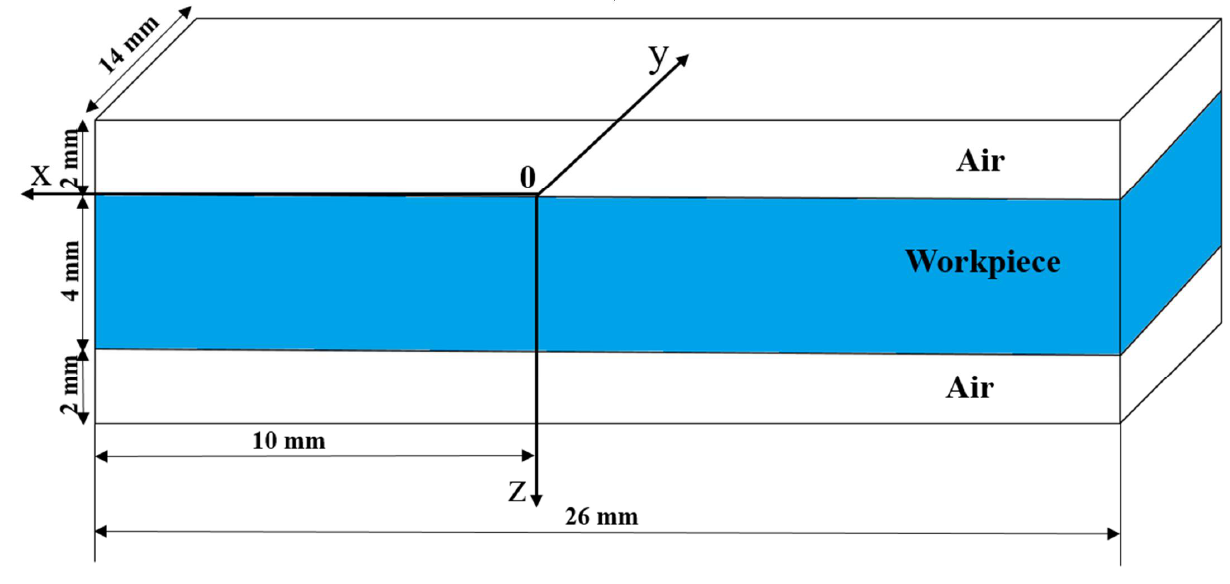
Figure 4. Calculation domain.